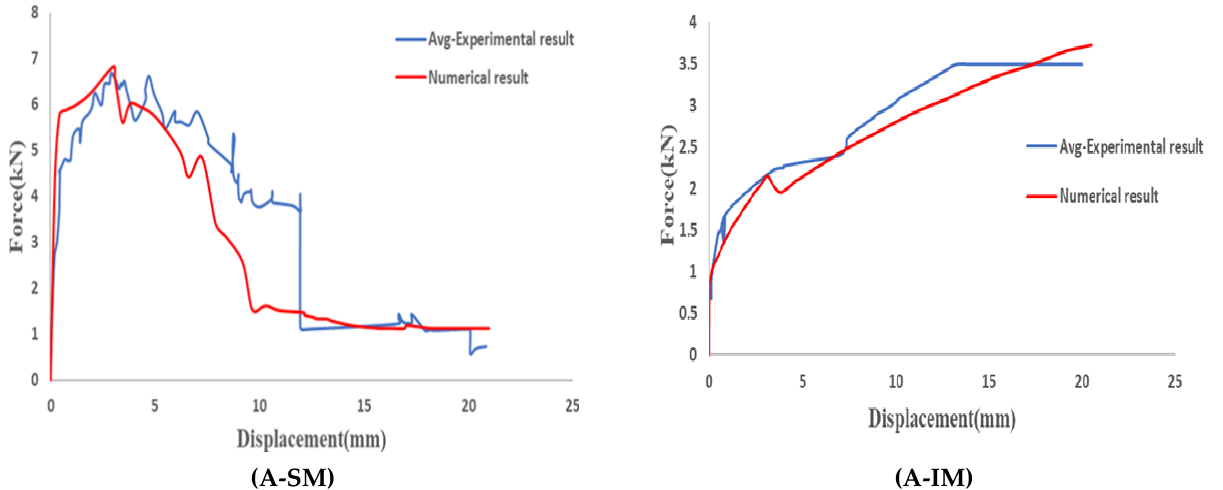
Figure 9. Force – displacement plots for the numerical models and experimental specimens. Figure 9. Force–displacement plots for the numerical models and experimental